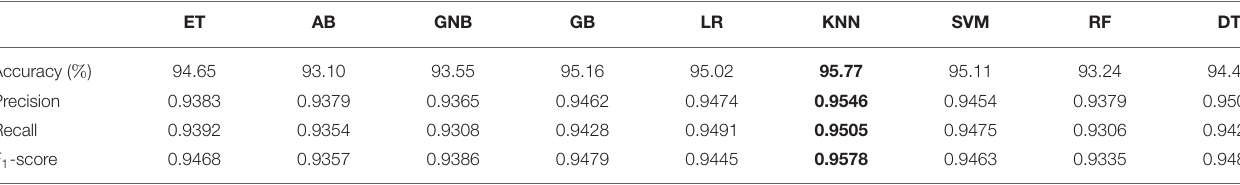
TABLE 1 | Model performance comparison between ET, Extra trees classifier; AB, AdaBoost; GNB, Gaussian Naive Bayes; GB, gradient boosting; LR, logistic regression; KNN, K-nearest neighbors; SVM, support vector machine RF, random forest; DT, decision trees